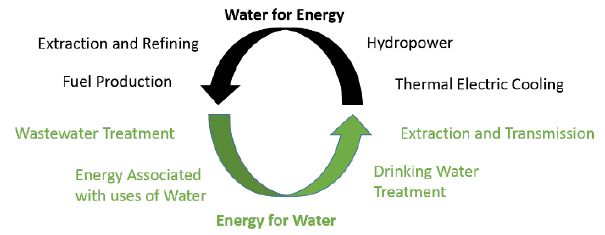
Figure 1. Defining the water energy nexus (after WEC,